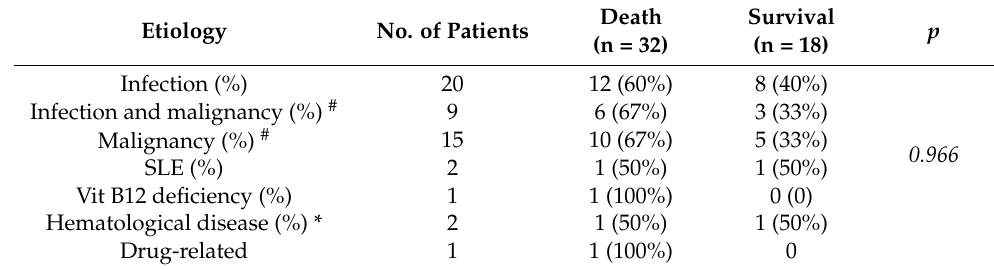
Table 2. Mortality and survival rates in patients with different etiologies of HLH.